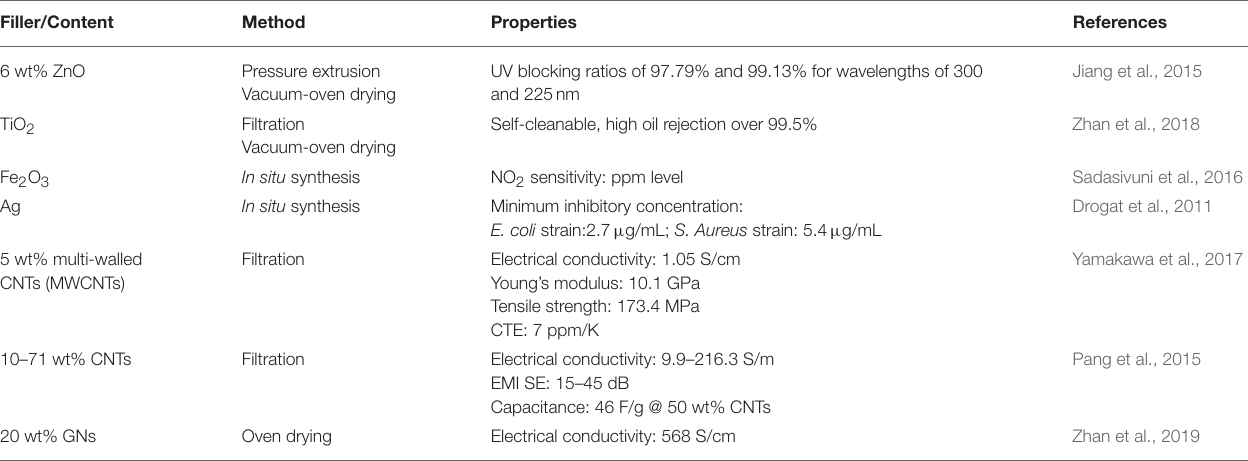
TABLE 1 | Multifunctional properties of cellulose